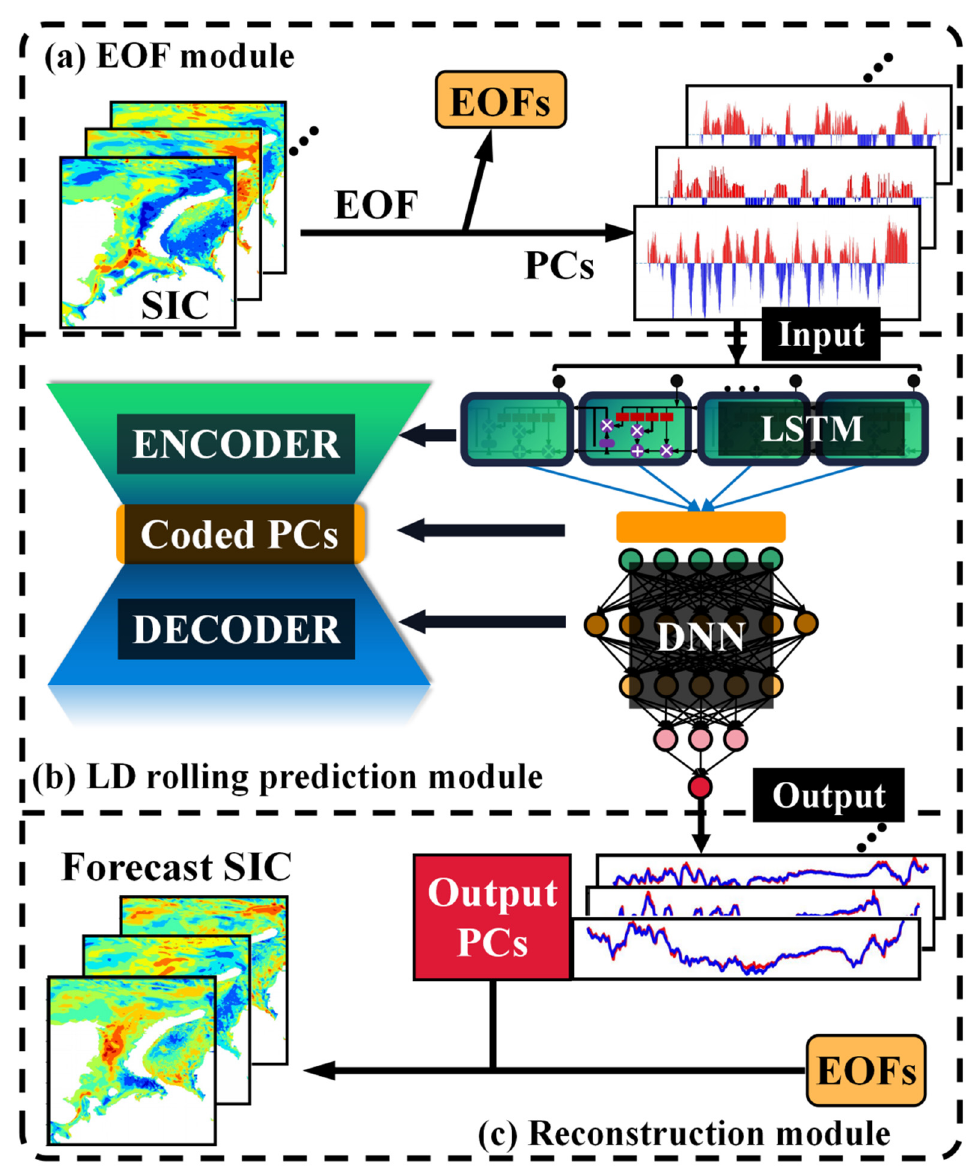
Figure 2. The architecture of the ELD model.